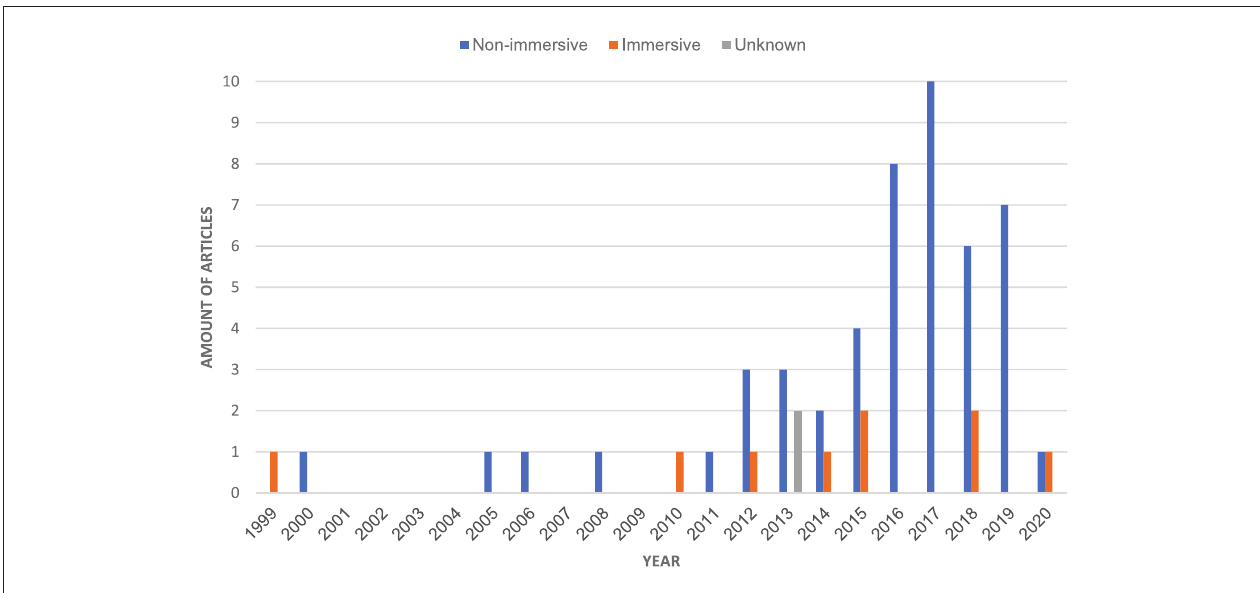
FIGURE 8 | Frequency plot of the articles ( n = 60), published between 1999 and 2020, which were excluded in the eligibility assessment, who used "Virtual Reality" to refer to the intervention. The graph shows interventions post-classified as immersive or non-immersive, by the authors, according to the taxonomy of virtual rehabilitation systems (see Figure 9